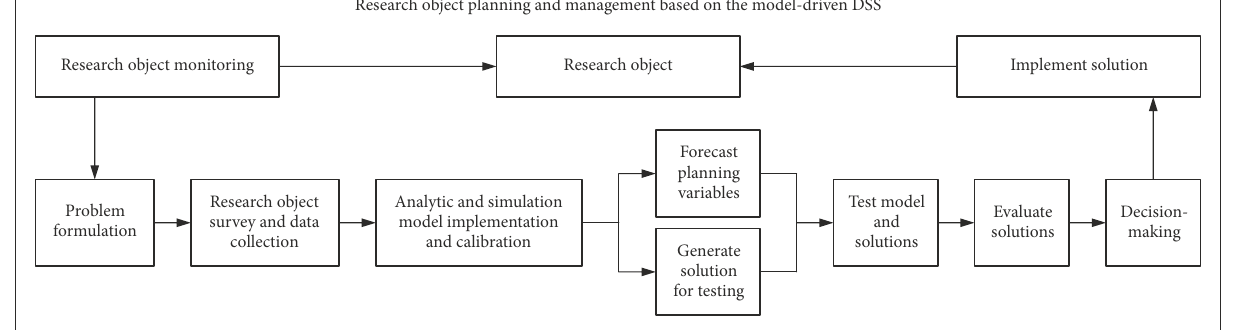
Figure 2. Framework of model-based